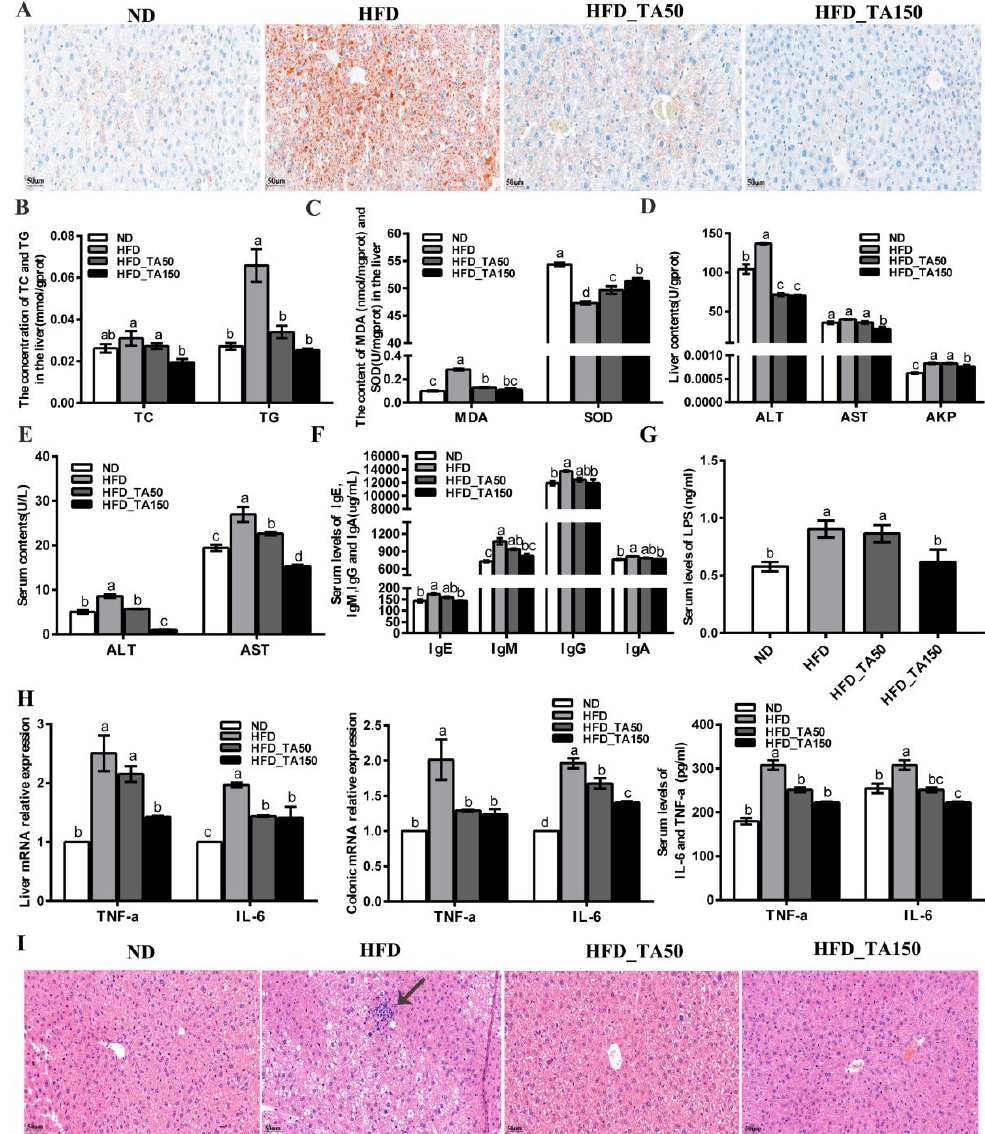
Figure 3. Effect of dietary tannic acid on liver lipid accumulation, oxidative stress, liver toxicity and systemic inflammation in mice induced by high-fat diet. ( A ) Hepatic histopathologic appearance by Oil Red staining, ( B ) the concentration of TC and TG in the liver, ( C ) the content of MDA and SOD in the liver, ( D ) the content of ALT, AST and AKP in the liver, ( E ) the content of ALT and AST in serum, ( F ) the content of IgE, IgM, IgG and IgA in serum, ( G ) the content of LPS in serum, ( H ) the content of TNF- α and IL -6 in serum, liver, and colon, ( I ) hepatic histopathologic appearance by H&E staining. Black arrows indicate the inflammatory infiltration structure. Data are expressed as mean ± SEM. Different letters between any two groups indicated that there was significant difference between the two groups ( p < 0.05).